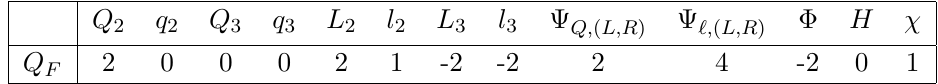
Table 2 . U(1) F family symmetry charges for the second and third